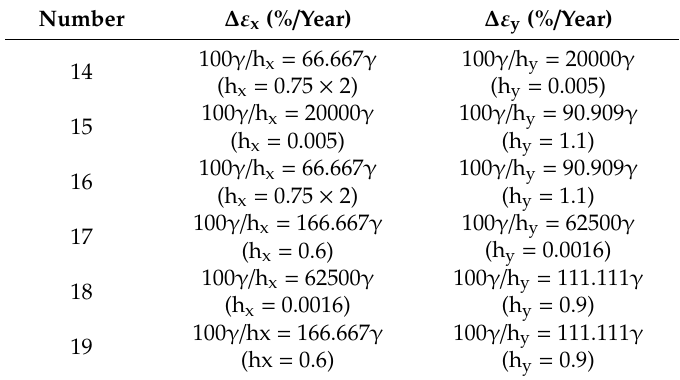
Table A6. Distortion increasing rate for the steel packages. γ represents corrosion swelling rate.